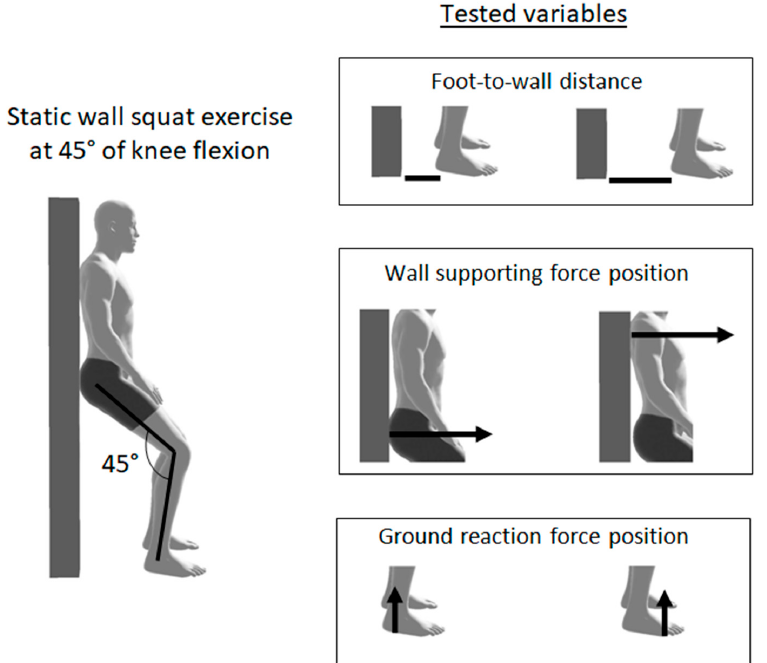
Figure 1. Sketch illustrating the static wall-squat exercise executed with knees flexed at 45 ◦ ( left panel ) and the two different conditions for each of the three exercise variables ( right panels ): (1) horizontal distance d of the ankles from the wall ( d 1 = 0.5 · l thigh and d 2 = l thigh ); (2) scapular or pelvic location of the centre of pressure C wall of the wall-supporting force; (3) rearfoot or forefoot location of the centre of pressure C GR of the ground reaction force.